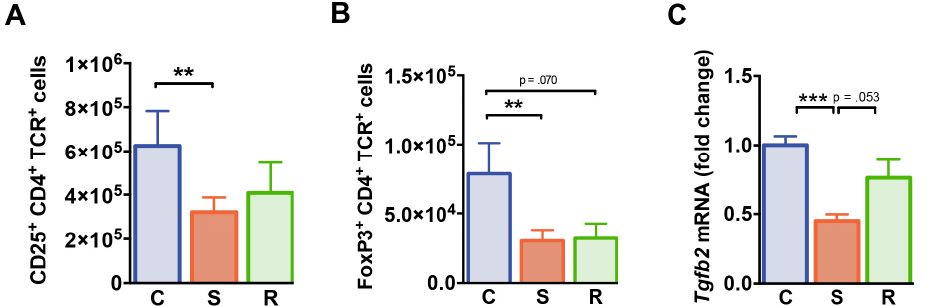
Figure 5. T regulatory cells. ( A ) Numbers of CD25 + CD4 + T cells. ( B ) Absolute numbers of FoxP3 + CD4 + T cells. ( C ) mRNA expression of Tgfb2 in splenocytes. Expression levels were normalized to the mean expression of housekeeping genes Gapdh and Hsp90ab1. Fold changes were calculated relative to control mice. Bar graphs represent mean + SEM. C: control, S: susceptible, R: resilient. n C = 15, n S = 16, n R = 11. **: p < 0.01, ***: p < 0.001 (Bonferroni post hoc).